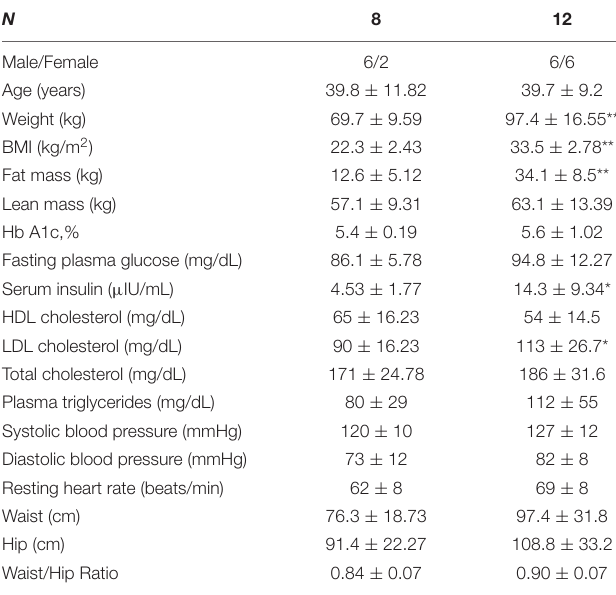
TABLE 1 | Participant